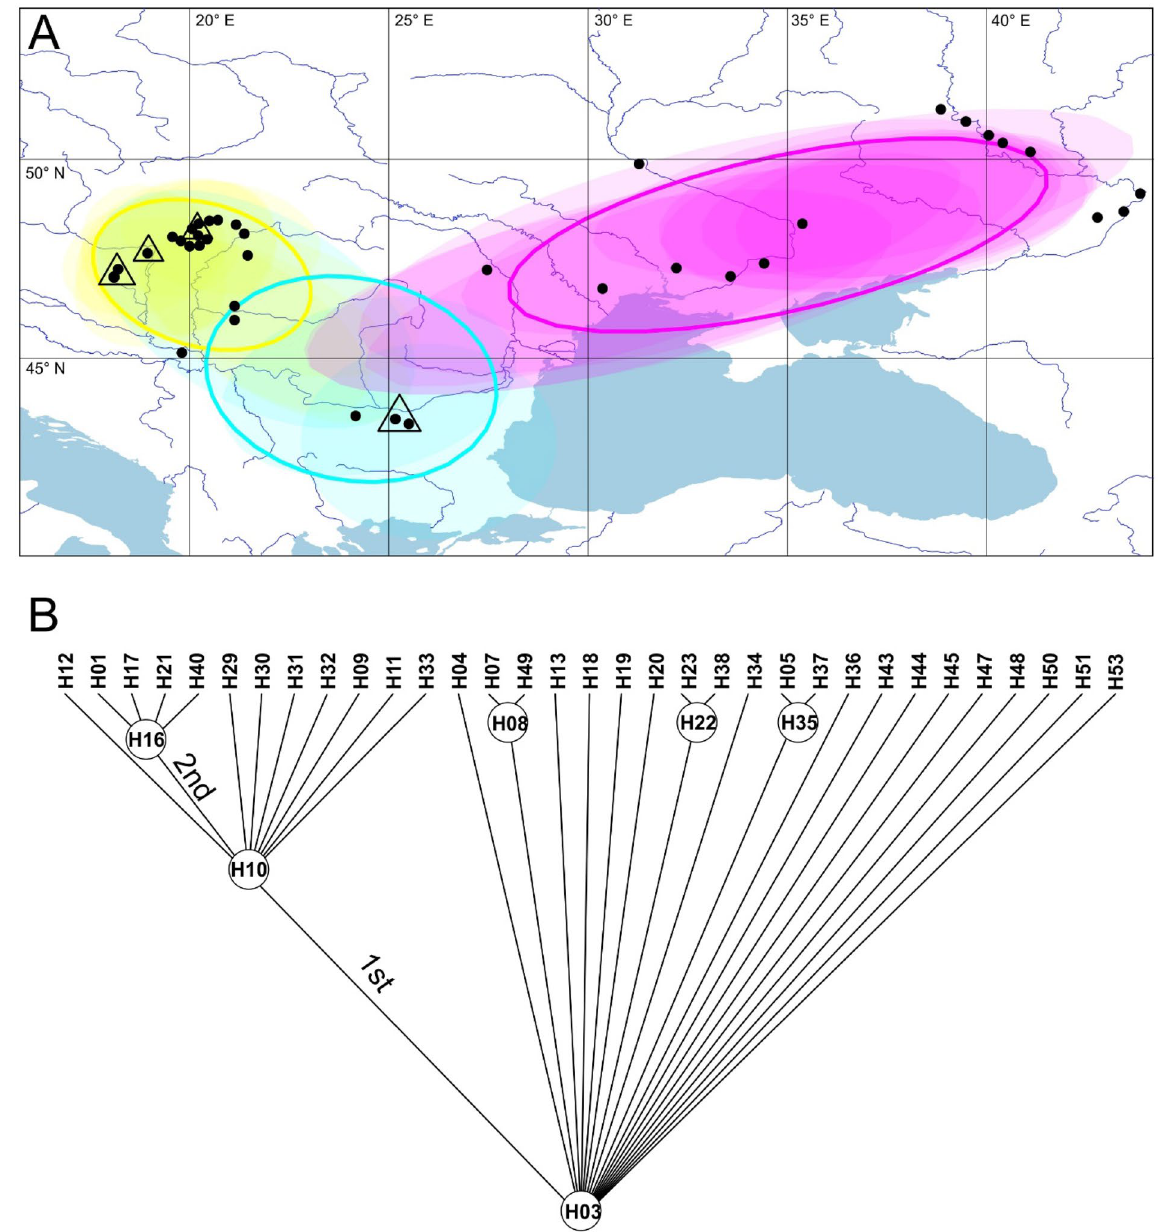
Figure 3. Clustering of populations based on their mitochondrial COI sequences from a Bayesian phylogeographic clustering analysis as implemented in BPEC. (A) The three clusters identified by the software are shown in different colours, their spatial coverage is drawn with a transparent ellipses representing the 50% highest posterior density in each run, whereas the solid lines represent posterior means. Triangles represent most likely ancestral areas with size proportional to the probability of being ancestral. (B) Phylogenetic relationship of mitochondrial haplotypes as reconstructed by BPEC using relaxed parsimony on a maximum a posteriori haplotype tree. Internal haplotypes are encircled, and two migration events (i.e., the emergence of a new cluster formed through the migration/dispersal/colonisation of a single haplotype leading to a new geographically distinct cluster) are also indicated next to the corresponding